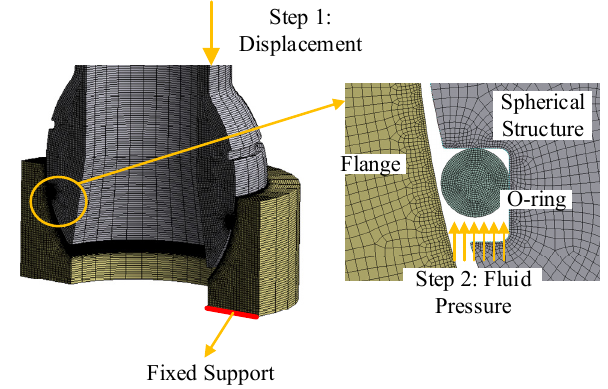
Figure 7. Diagram of O-ring sealing structure grids.